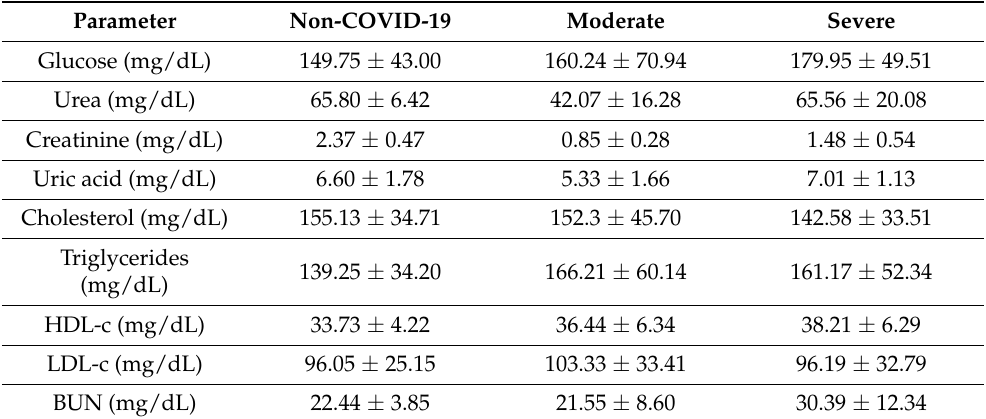
Table 3. Parameters of serum evaluations. Values represent mean ± standard deviation.